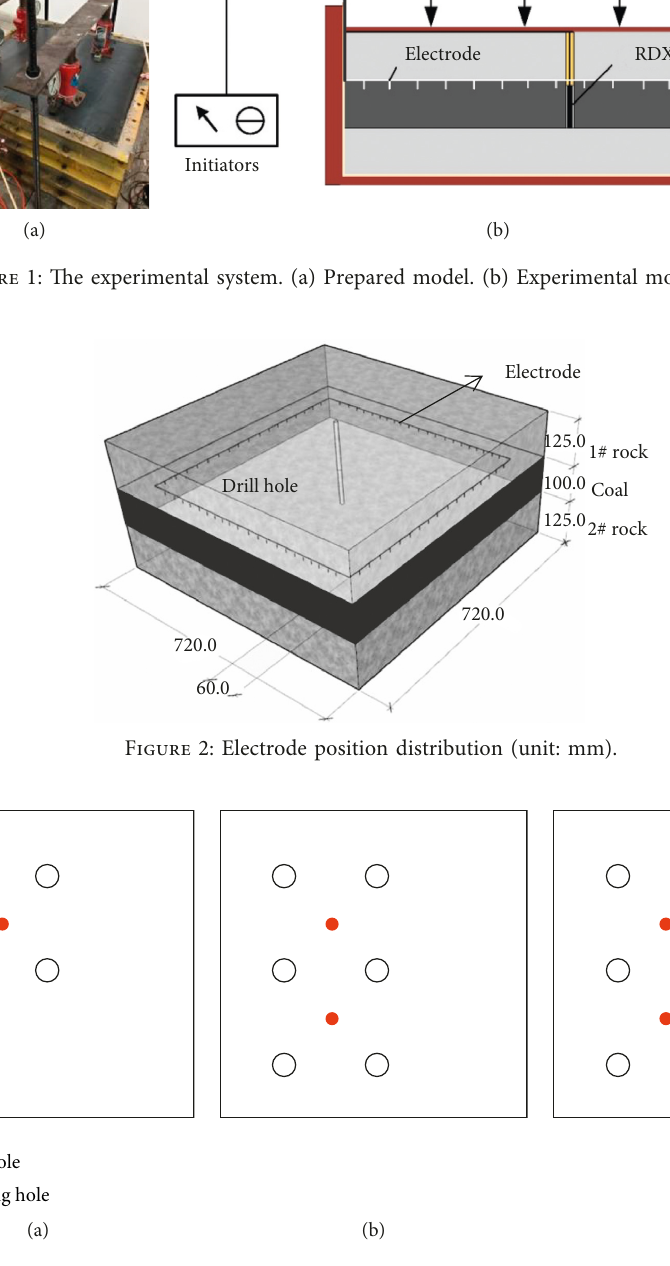
Figure 3: The blasting models. (a) Single-hole blasting model. (b) Double-hole blasting model. (c) Four-hole blasting model. Table 2: Drilling